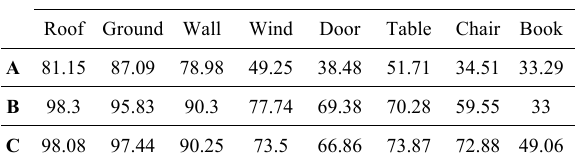
Figure 6 . A portion of the S3DIS dataset coloured (a) and hand-annotated (b), with its classification results achieved using clustering features (c), geometric features in a multiscale approach (d), combining clustering and geometry-based features (e). F1 scores